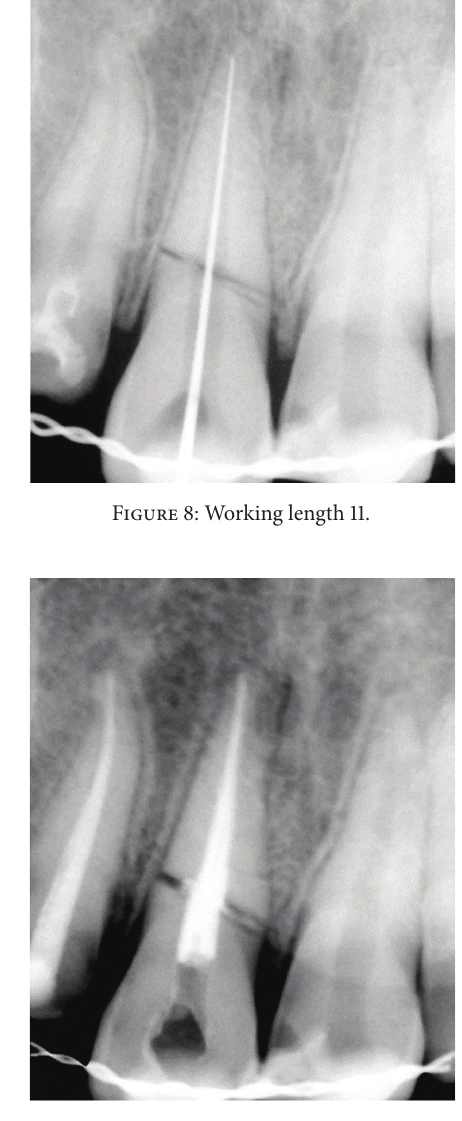
Figure 9: Obturation 11.